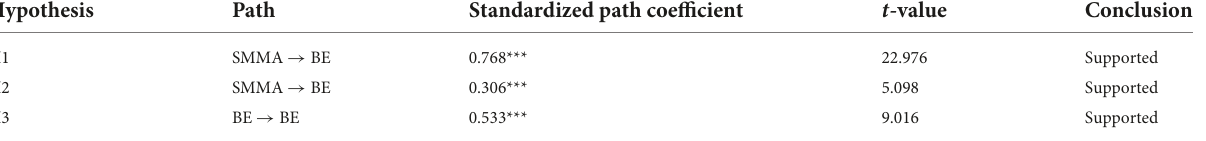
TABLE 8 Summary of hypothesis testing